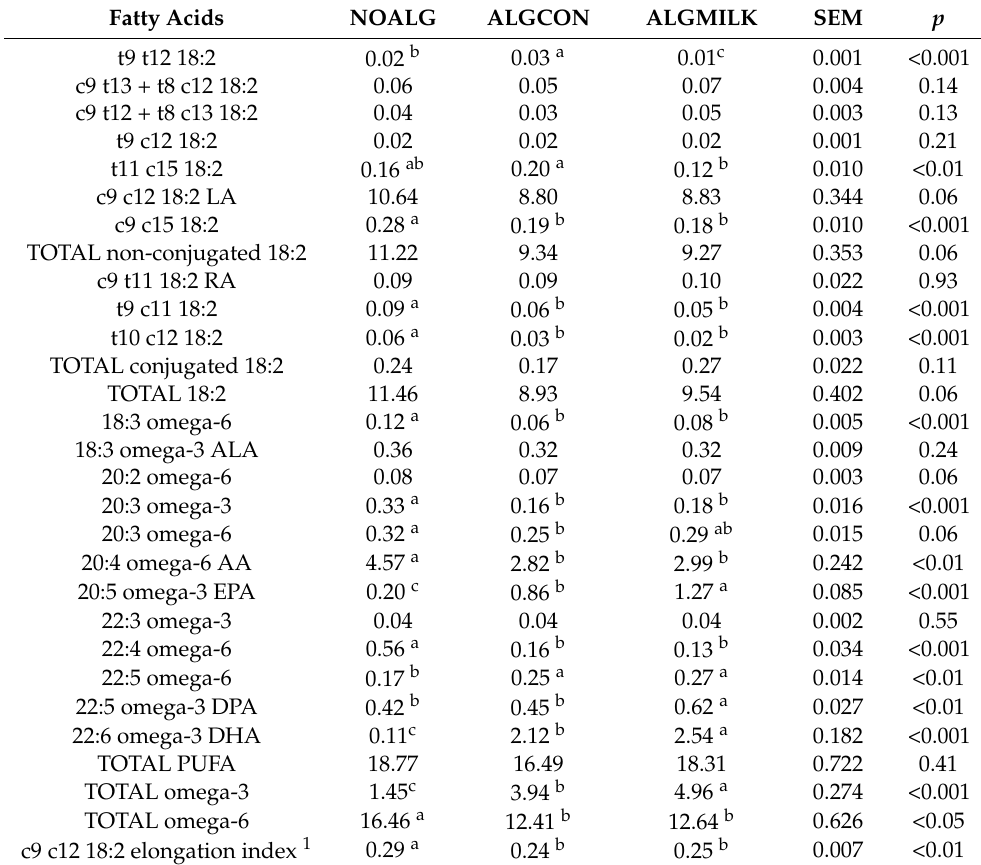
Table 4. Polyunsaturated fatty acid (PUFA) profile (g/100 g of total fatty acid methyl esters) in intramuscular fat of feedlot lambs fed a conventional diet alone (NOALG) or feedlot lambs with competent reticular groove reflex fed the same diet supplemented with 2.5% of algae meal, either mixed in the concentrate (ALGCON) or in the milk replacer